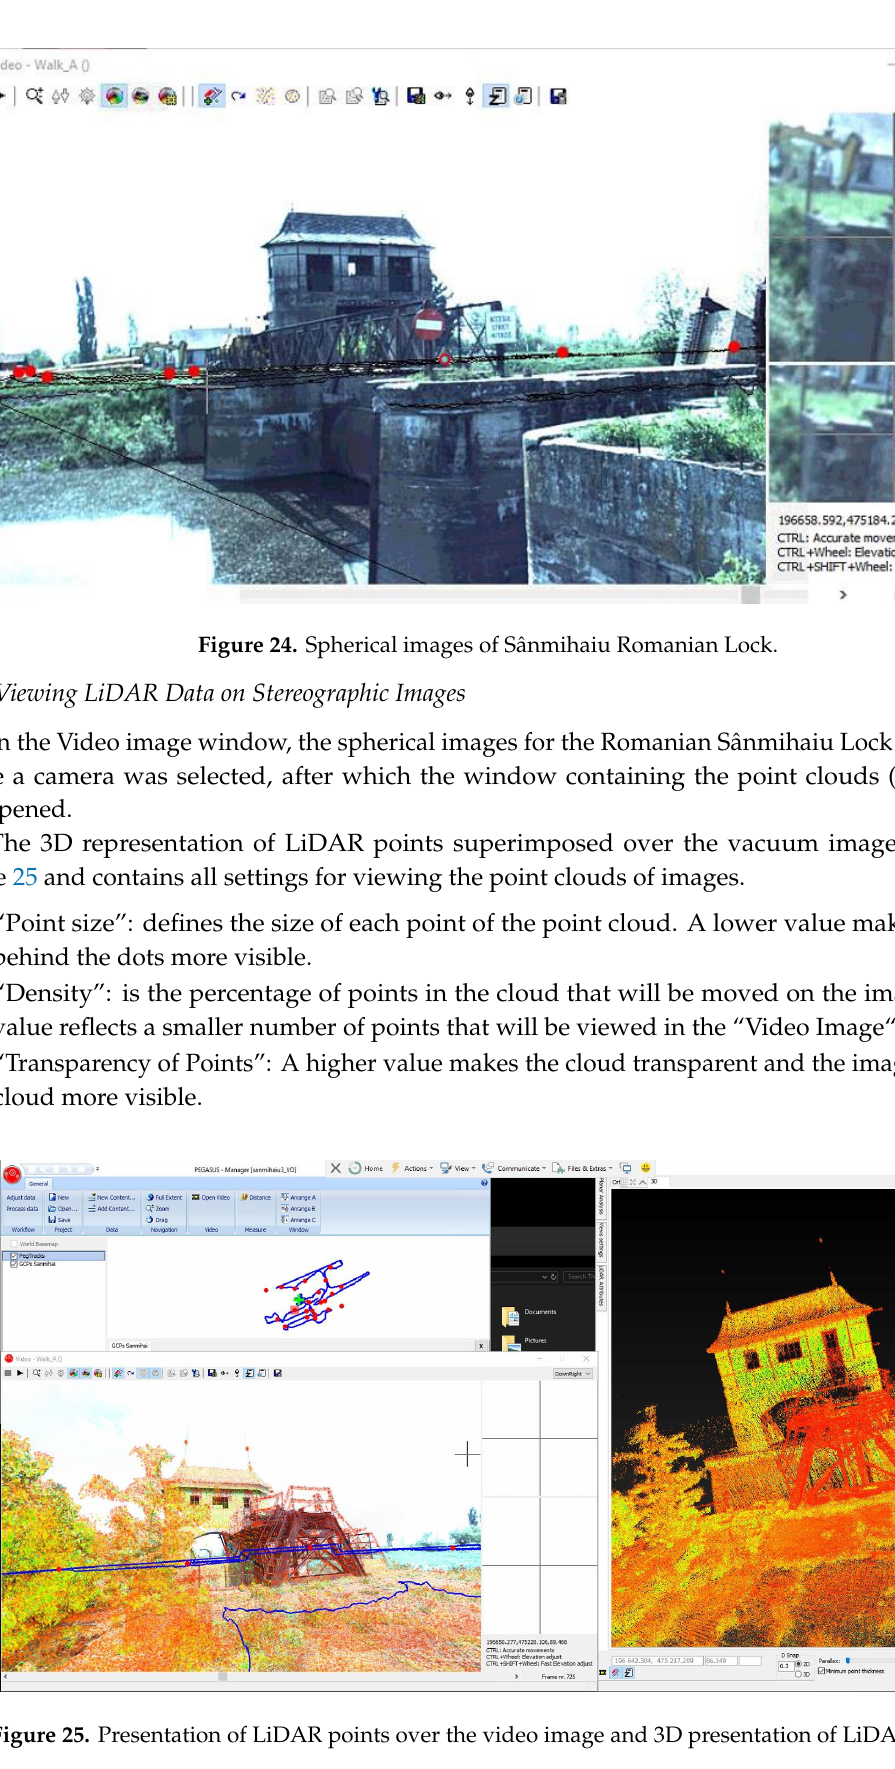
25 of 39 Figure 23. Video images of Sânmihaiu Romanian Lock.